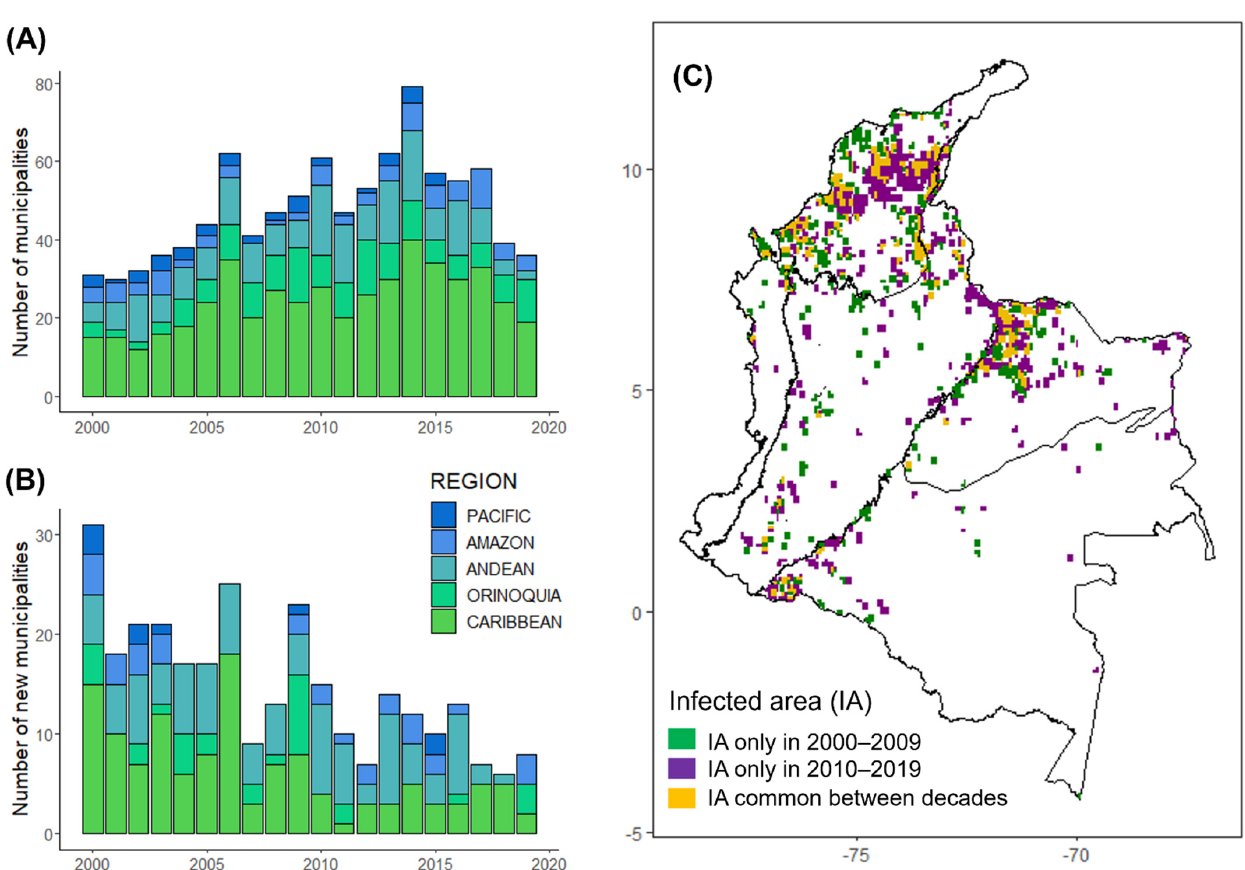
Figure 2. Annual number of municipalities and infected areas in Colombia from 2000 to 2019: ( A ) Bars represent the annual number of municipalities reporting VBR outbreaks; ( B ) Bars represent the annual number of ‘new municipalities’ reporting VBR outbreaks for the first time. Each bar division illustrates a biogeographic region; ( C ) Comparison between the infected area (IA) in the second (2010–2019) and the first (2000–2009) decade of the study. ‘New infected areas’ were considered as cells reporting VBR outbreaks in the second decade that did not report outbreaks in the first decade (cells in purple), whereas cells reporting outbreaks in both decades were considered as ‘endemic areas’ (cells in yellow). The infected area was estimated using a bandwidth = 0.01 that generated a 10 km 2